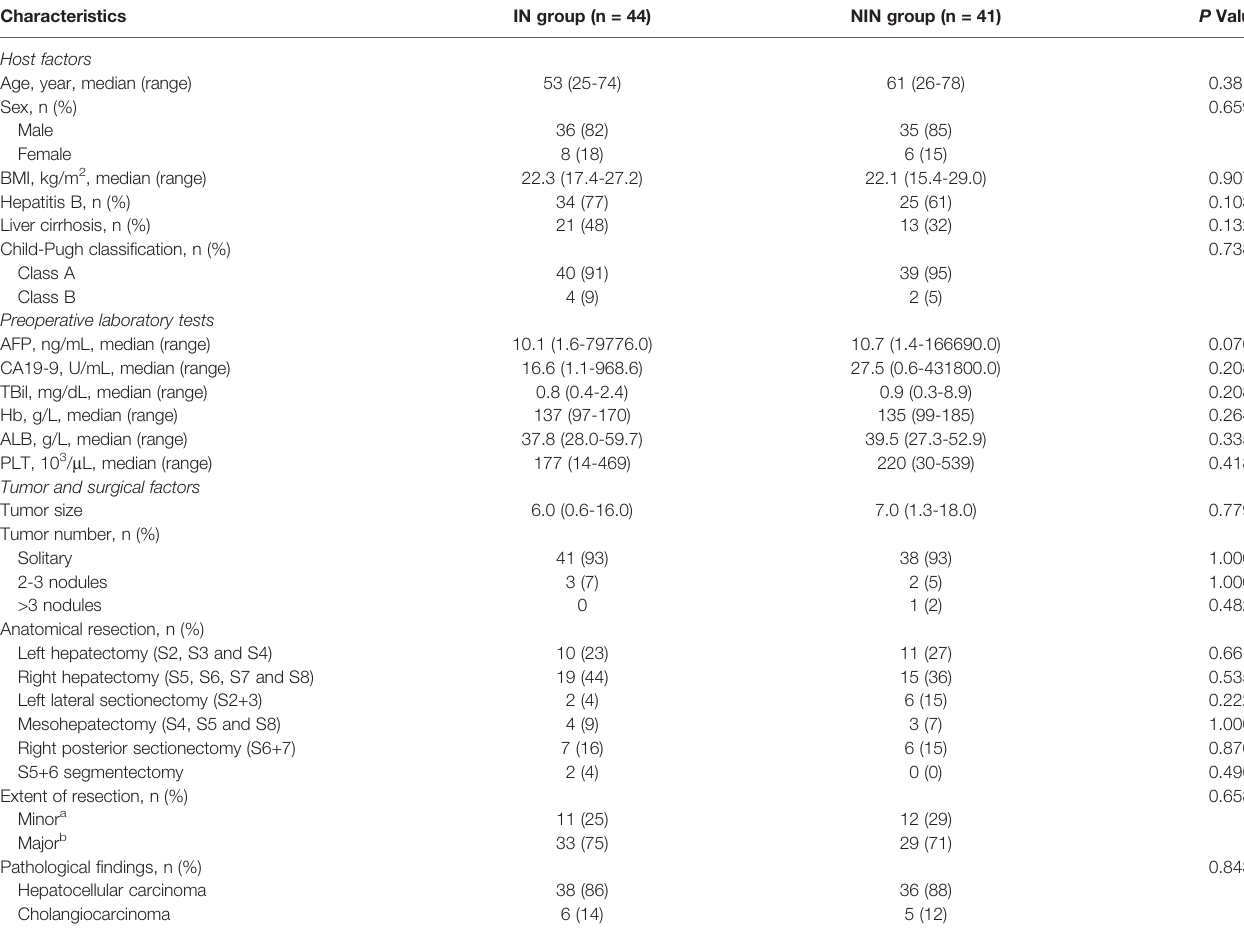
TABLE 1 | Patient Characteristics.